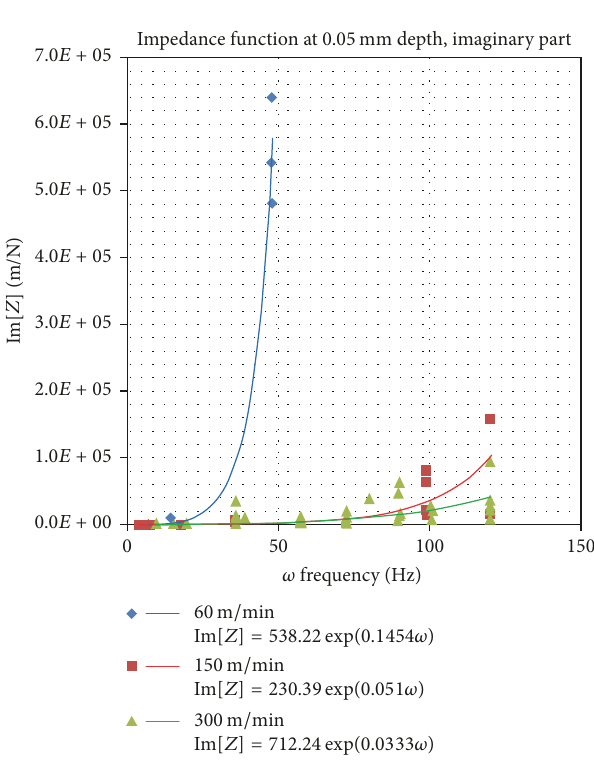
proposed curves of (9) were obtained (Tables 2 and 3). The constants 𝐴 𝑖 , 𝐵 𝑖 , 𝐸 𝑖 , and 𝐹 𝑖 of the parameters were obtained using (11). The values of these constants are shown in Tables 4 and